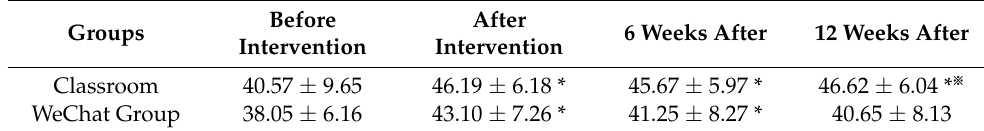
Table 6. Changes in self-efficacy questionnaire scores (N =